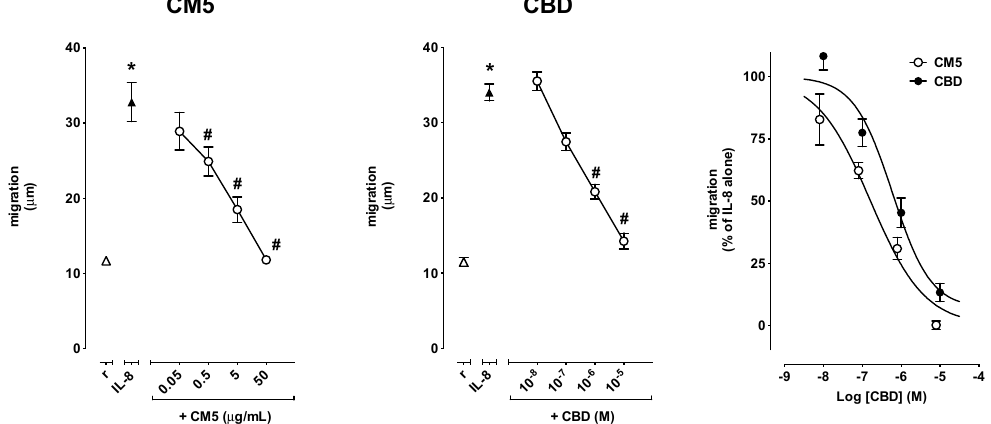
Figure 4. Effect of CM5 and CBD on IL-8-induced PMN migration shown as absolute values (left and centre panels) and as the percent of inhibition of migration of fMLP–stimulated PMN (right panel). Values are mean ± SD of at least 5–13 experiments. * p < 0.001 vs. resting and # p < 0.001 vs. IL-8 alone. Table 1. IC 50 values of the Log concentration–response curves of CM5 and CBD on PMN functions. Data are expressed as log (M) of CBD. CM5 CBD PMN Functions p -Value (Mean ± SEM) (Mean ± SEM) fMLP-induced migration − 7.401 ± 0.111 − 6.645 ± 0.106 0.0008